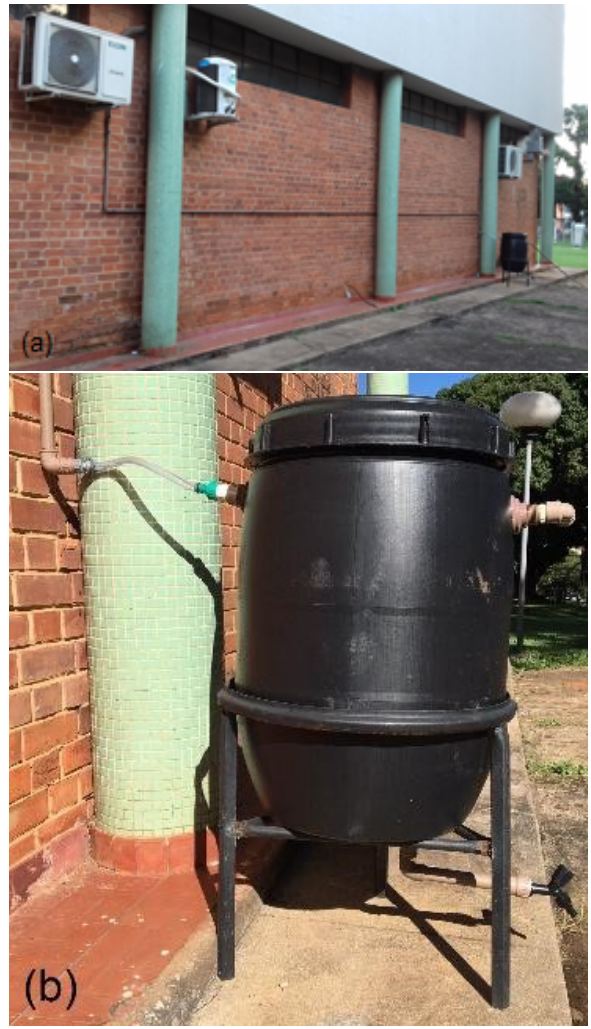
Figure 1: The water storage and collection system located